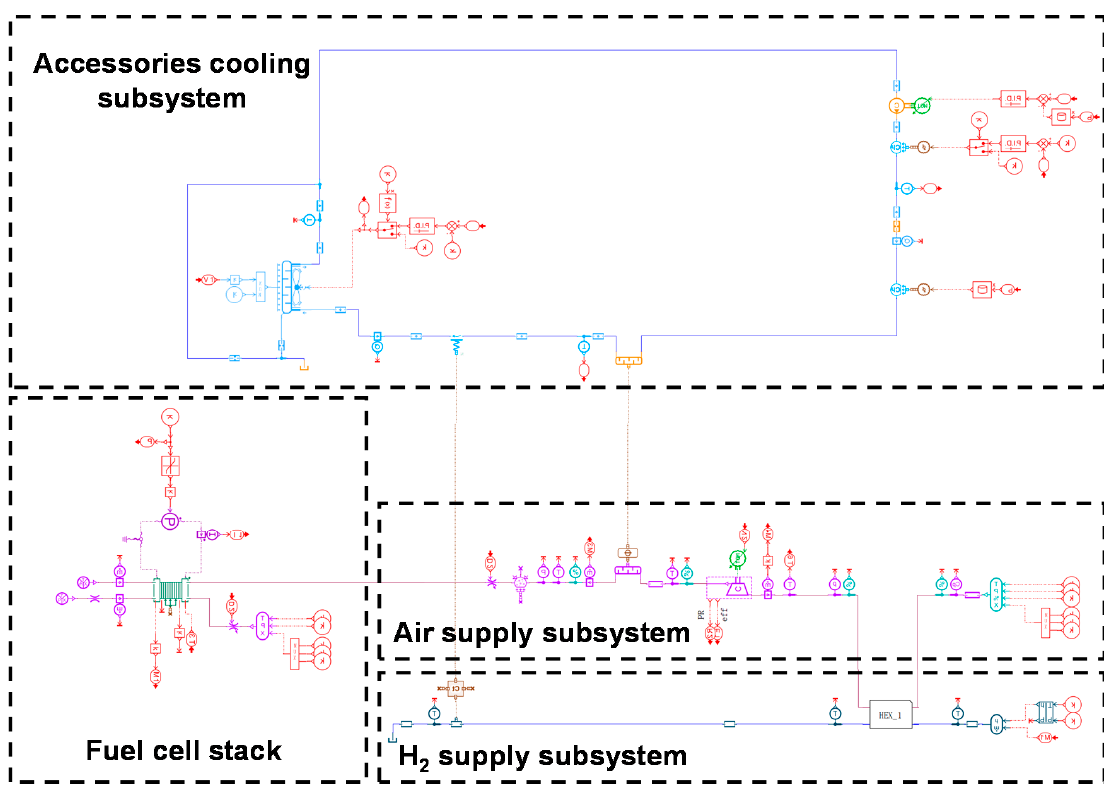
Figure 4. System model in AMESim.